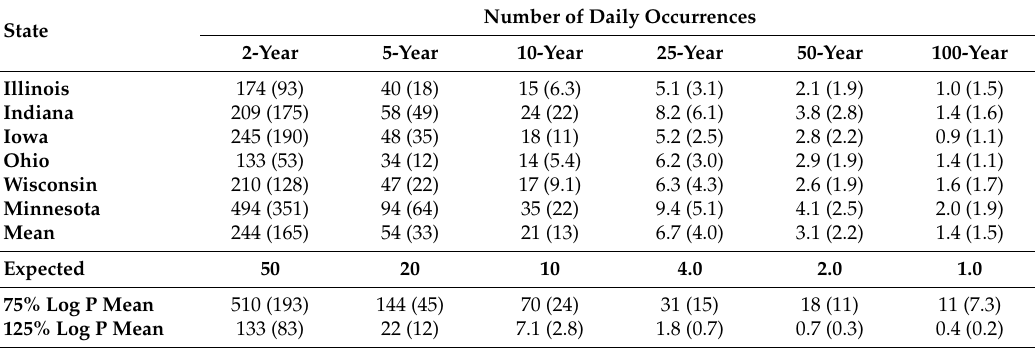
Table 3. Calculated number of daily occurrences in a 100-year time period for different recurrence interval discharge events for each state. Standard deviation reported in parentheses. The expected number of occurrences and the number associated with discharges that are 75% and 125% of the calculated Log-Pearson Type 3 values are also